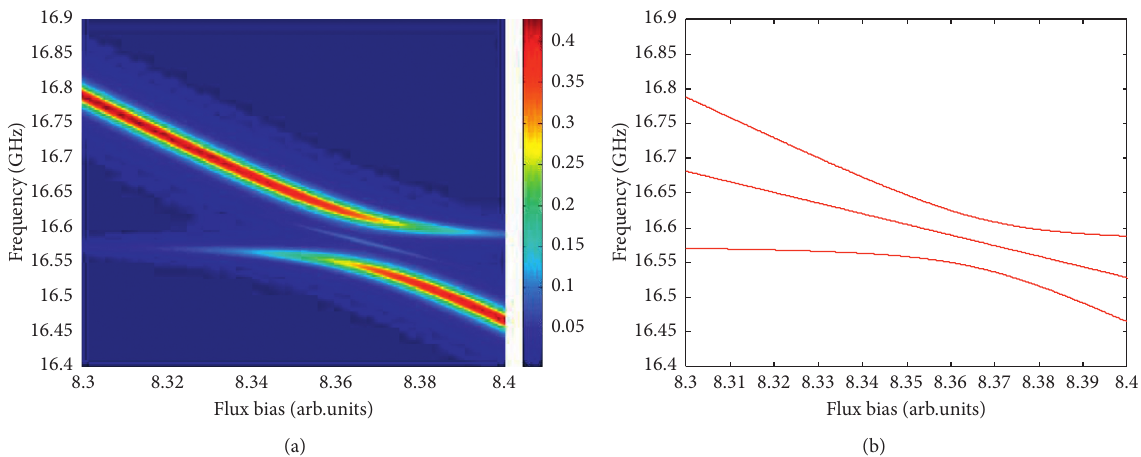
Figure 1: (a) One avoided level crossing near 16 . 57 GHz is shown in the spectroscopy of the superconducting phase qubit. (b) The simulated excitation spectrum of the superconducting